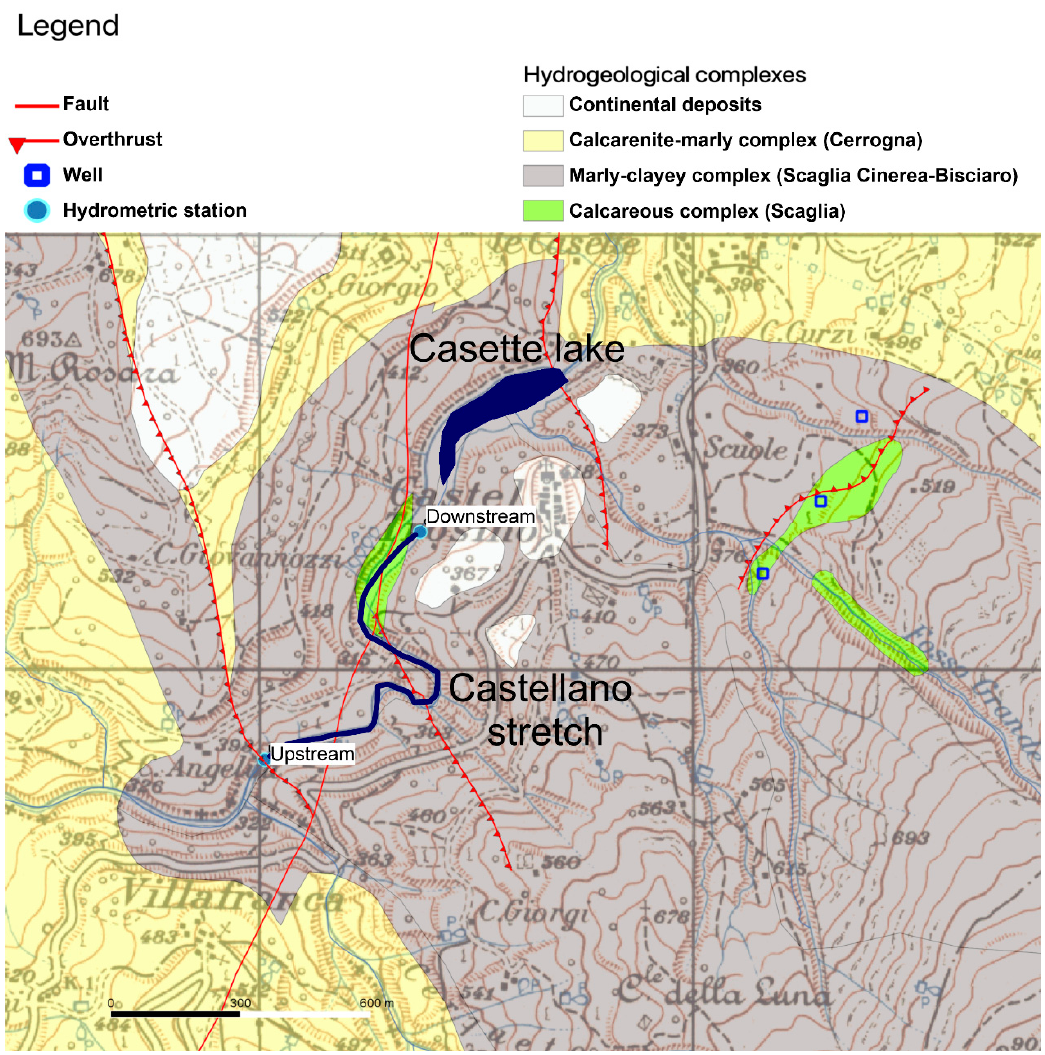
Figure 2. Hydrogeological map of the Casteltrosino area used to characterize in detail the domain of the numerical model in the area of the wells field.